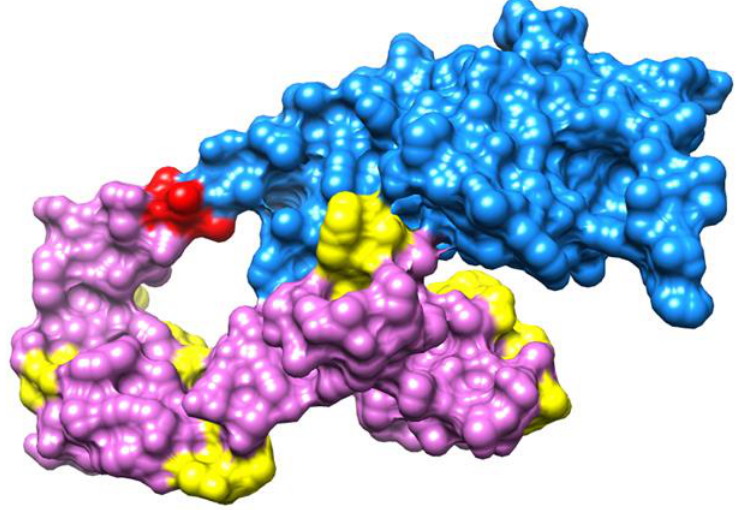
Figure 4. A visualization of the MEV construct. The yellow color represents GPGPG linkers, blue color represents the cholera toxin B subunit, and red (EAAAK linkers) and orchid colors represent the epitopes.